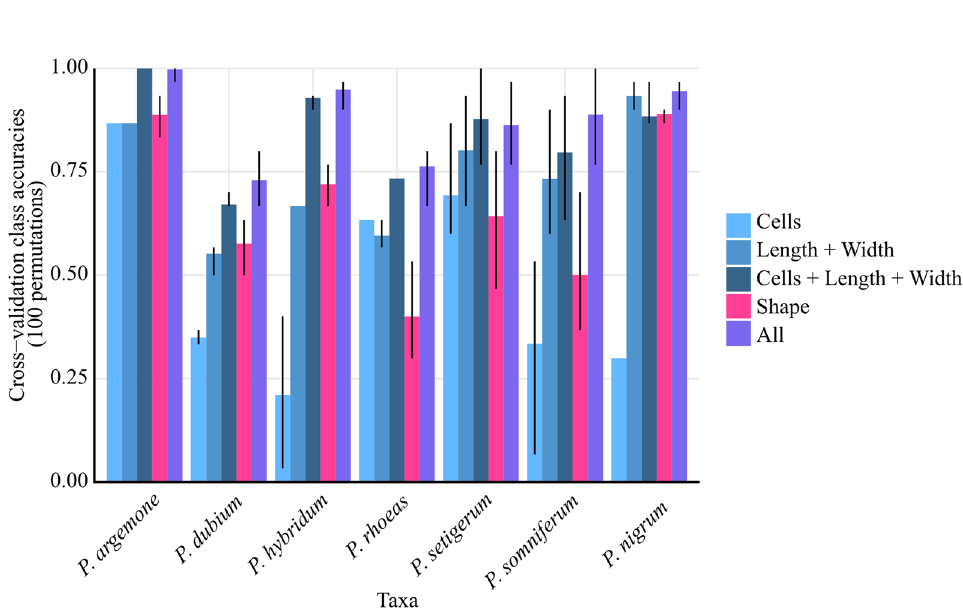
Figure 5. Benchmarking of linear discriminant analyses on all species and using different proxies. Accuracy per classes and their variability were obtained using 100 permutations on classes-balanced dataset with the error